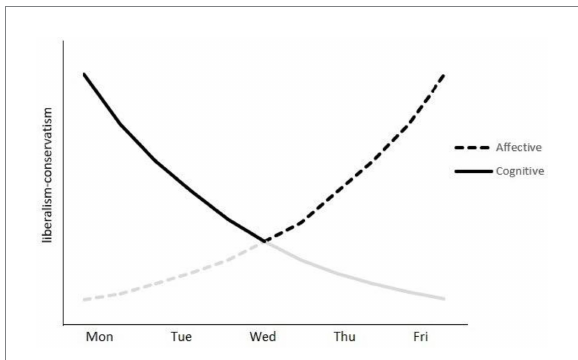
FIGURE 1 The cognitive and affective states hypotheses. Note. Weekends are not included as both cognitive and affective states hypotheses suggest the highest levels of liberalism-conservatism. The dark lines illustrated the predominant